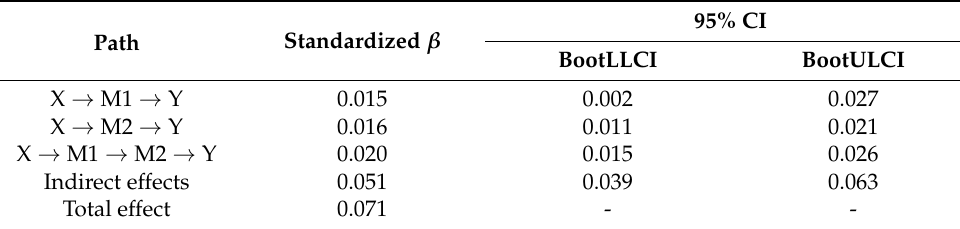
Figure 2. The chain mediation model. Note: the thin dotted line is not significant, and the solid black line is significant; covariates are not shown in the model diagram. * p < 0.05, *** p < 0.001. Table 2. Bias-corrected bootstrap test on the mediating effects.